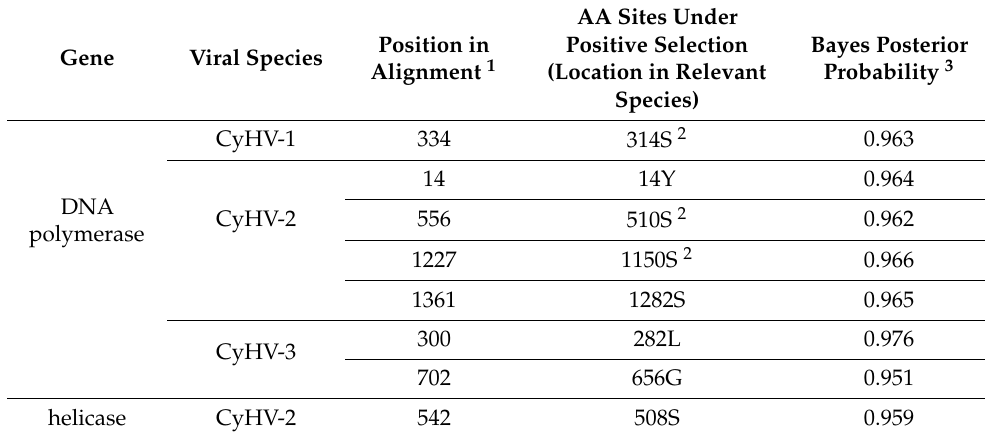
Table 3. Summary of AA changes identified as having been driven by positive